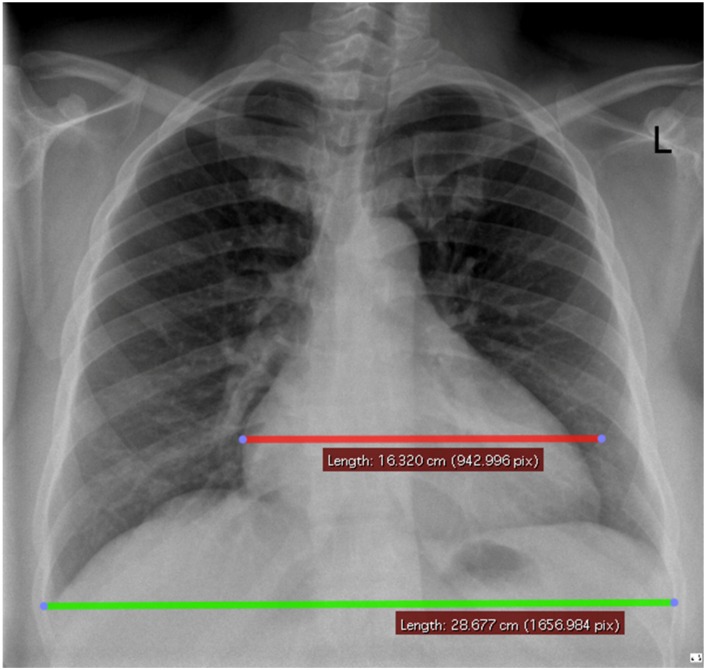
Method for determining Cardiothoracic Ratio.Digital Posterior-Anterior Chest Radiograph (CXR) with maximal cardiac diameter in red and maximal thoracic diameter in green. Cardiothoracic ratio (CTR) is 0.57.